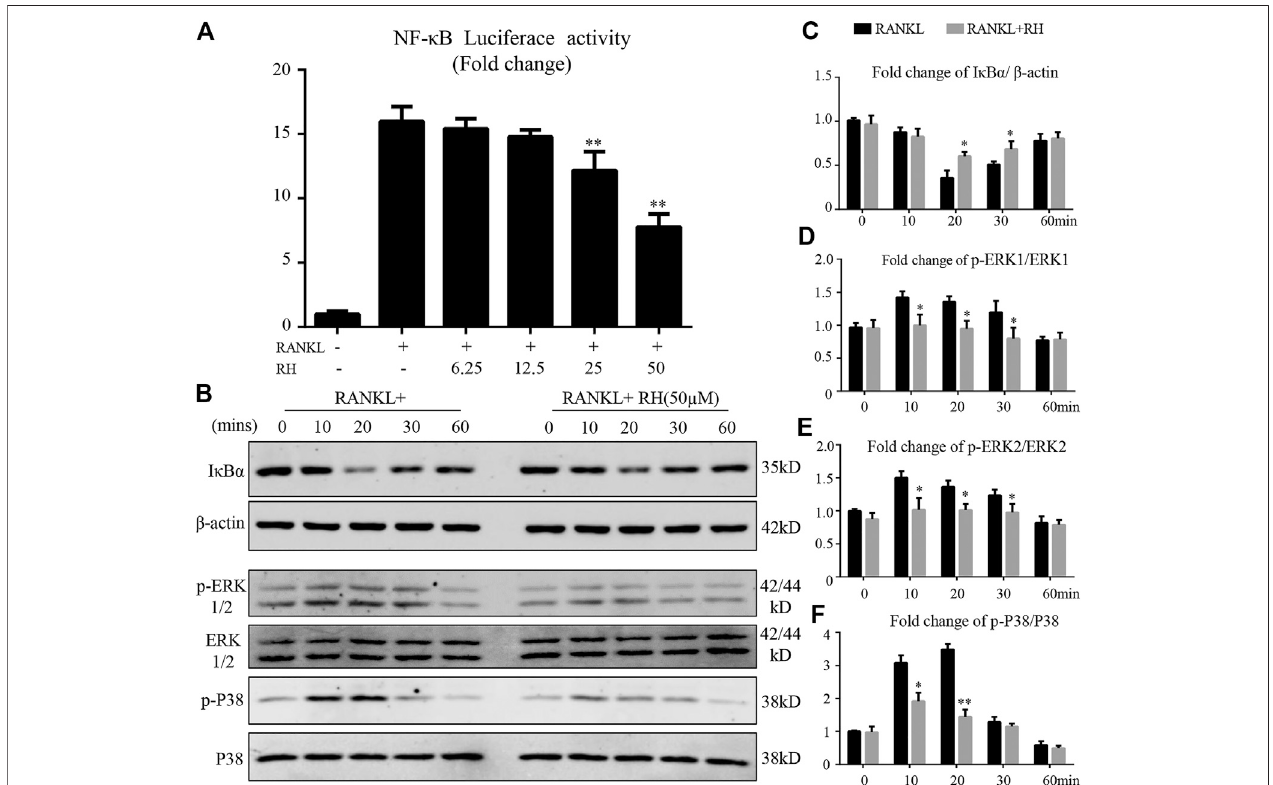
FIGURE6| RHsuppressedtheactivationofNF- κ BandthephosphorylationofERKandP38inducedbyRANKL. (A) RHinhibitedtheNF- κ BactivityofRAW264.7 cellswithluciferasereportconstructatthedifferentconcentrationsofRHasindicated.ThecellswerepretreatedwithvaryingdensitiesofRHandstimulatedwithRANKL at 50 ng/mL for 6 hours. (B – C) Representative images of the expression level of I ĸ B- α and β -actin in Western blot assay and the quanti fi cation of the ratios of band intensity of I κ B- α to β -actin. (B – F) Representative images of the expression phosphorylation level of ERK and P38 with or without the treatment of 50 μ M RH, and the quanti fi cation of the fold change ratios of band intensity of p-ERK to ERK and p-P38 to P38 ( n (cid:2) 3). * p < 0.05, ** p < 0.01 relative to RANKL-induced positive group.